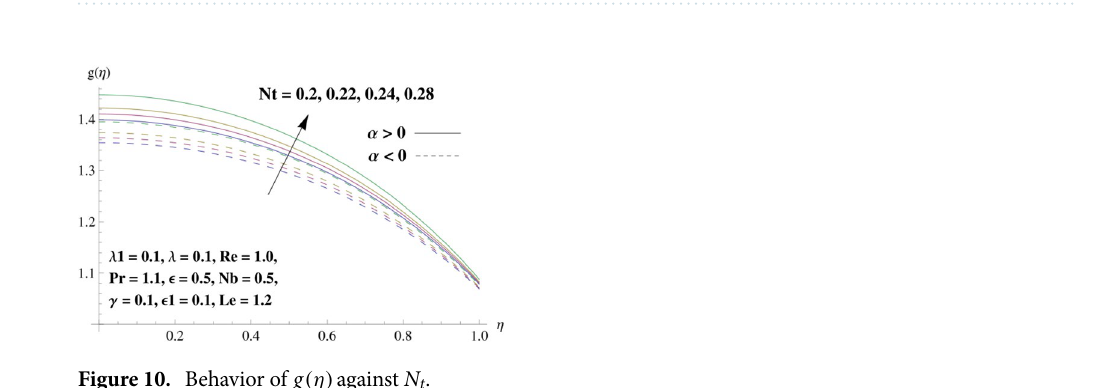
Figure 9. Behavior of g (η) against N b .